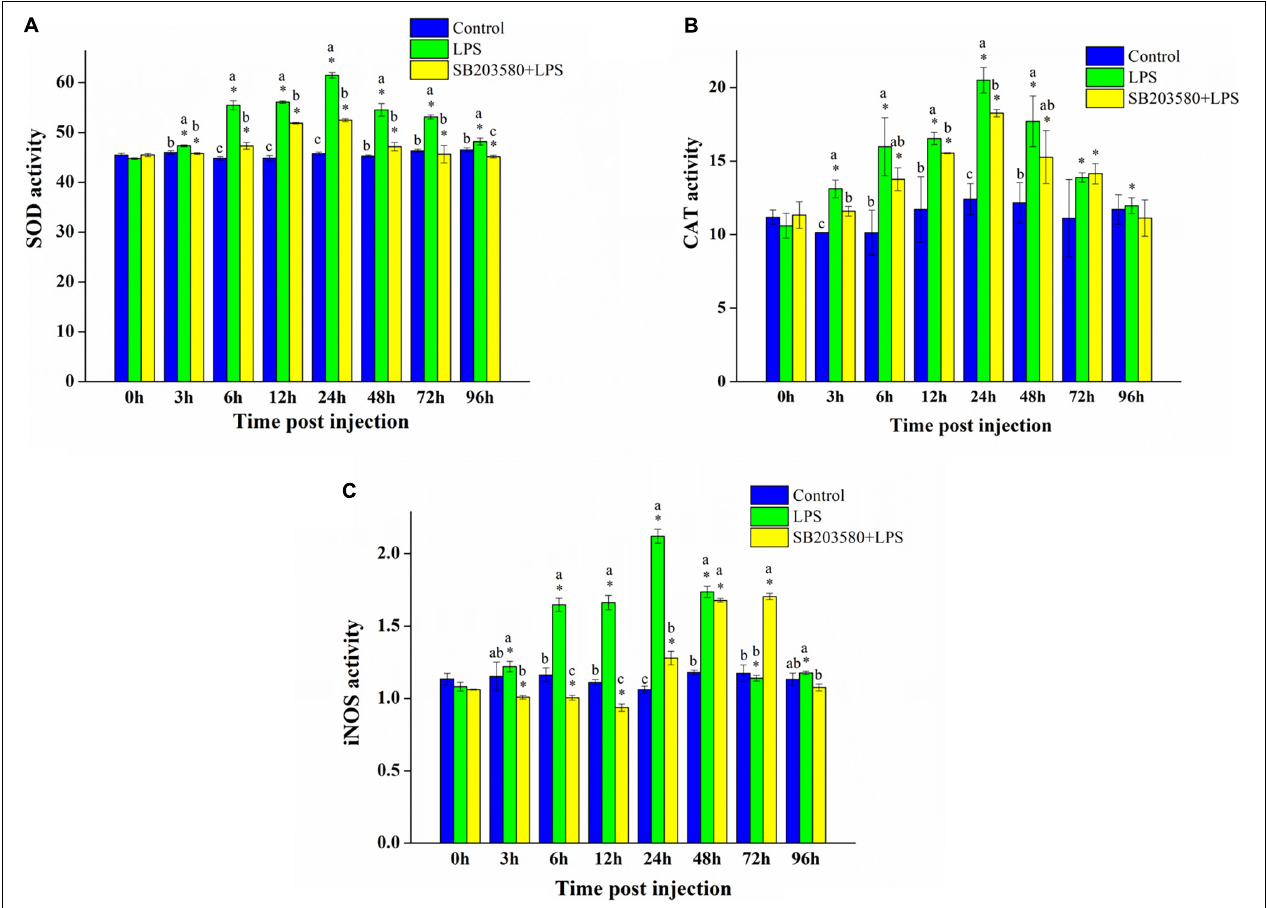
FIGURE 8 | Analysis of the SOD, CAT, and iNOS enzyme activity analysis under LPS stimulation. (A) Analysis of the SOD enzyme activity analysis under LPS stimulation. (B) Analysis of the CAT enzyme activity analysis under LPS stimulation. (C) Analysis of the iNOS enzyme activity analysis under LPS stimulation. Error bars represent the SD of three independent repeats, and the results are expressed as means ± standard deviation. Independent sample t -test analyzed the significant changes at different time points in the same treatment group. *Indicates a significant difference between this time point with 0 h. Duncan’s multiple comparison test analyzed the significant changes between different treatments at the same time point. a, b, and c indicate significant differences between treatment groups. P < 0.05 was considered statistically